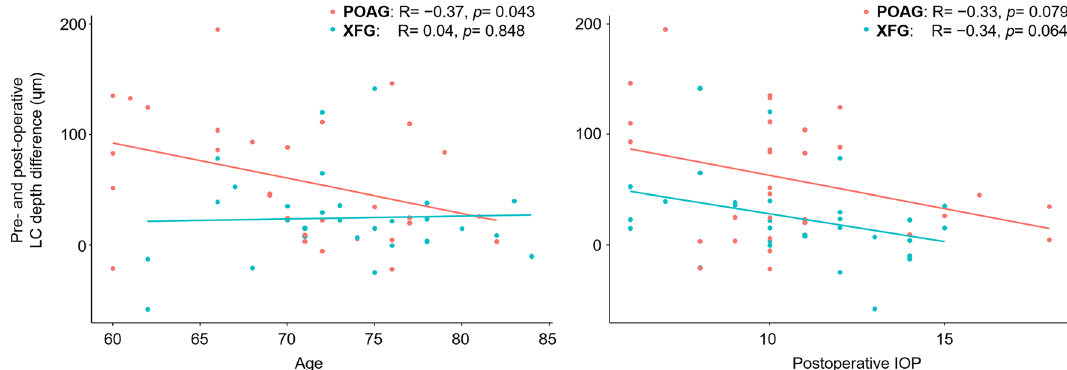
Figure 1. Left panel—Correlation plots between pre- and postoperative lamina cribrosa (LC) depth difference and age in eyes with primary open-angle glaucoma (POAG) and those with exfoliation glaucoma (XFG). Right panel—Correlation between pre- and postoperative LC depth difference and postoperative intraocular pressure (IOP) in POAG and XFG eyes. R: Pearson’s correlation coefficients.